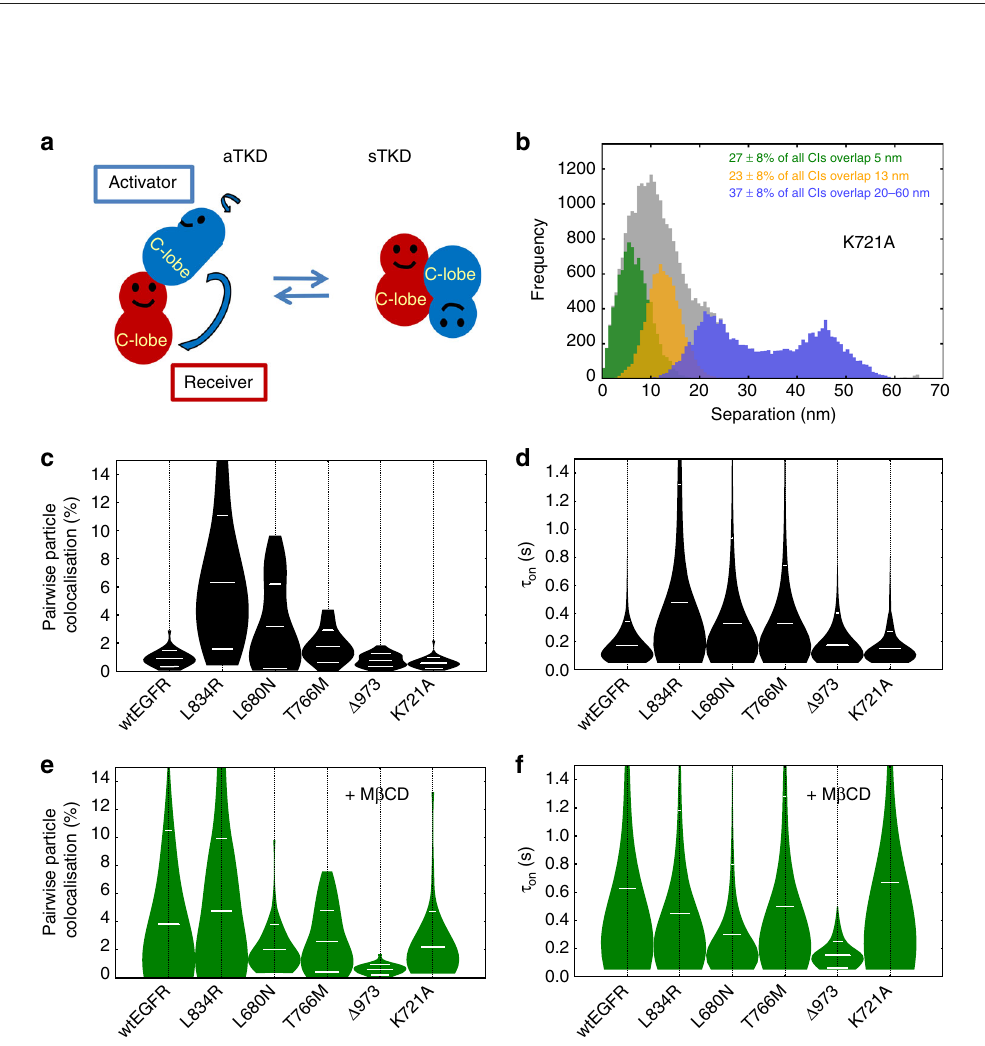
Fig. 6 Kinase-mediated regulation of ECM dimer geometry in cancer-associated intracellular mutants. a Kinase domain structure showing the positions of relevant amino acids. b Fractions of FLImP measurements whose ranges of 69% con fi dence overlap with the ranges of DIII – DIII separations expected for dimers (0 – 15 nm) (pink) or oligomers (20 – 60 nm) (blue) collected from cells expressing the receptor mutants and/or under the conditions noted in the X - axis. The associated FLImP distributions are in Supplementary Fig. 18. c – e The FLImP distributions (grey) and the distributions compiled from the FLImP measurements whose 69% CIs overlap with DIII – DIII separations = 5 nm (green), 13 nm (yellow), or >20 nm (blue) collected from cells expressing wtEGFR, Δ C-EGFR, Δ 698-EGFR, wtEGFR on cells treated with 1 μ M erlotinib, wtEGFR on cells treated with 10 mM M β CD, L834R-EGFR, L680N-EGFR, Δ 973-EGFR and T766M-EGFR. The insets show the fraction of separations consistent with each distance. Errors were assesed with bootstrap- resampling 12 . f Free-energy surfaces as a function of the helical content of the α C helix and the distance from the reference active conformation (a contact map corresponding to the active extended A-loop conformation) as obtained from PTmetaD simulations of the wtEGFR and T766M-EGFR mutant. The central structures of the most populated clusters are shown (left and middle). The A-loop is coloured green, while the α C helix is shown in purple if it forms an α -helix and in pink if it forms a 3 10 helix. Salt-bridge interactions formed at the dimer interface in the last µ s of the unbiased MD simulations of the symmetric dimers (right panel). The mean values and the standard deviations are calculated across monomers. The salt bridge was considered to be formed if the minimal distance between the side chains of residues in question was <4 Å. (More information on the calculations can be found in Supplementary Methods)